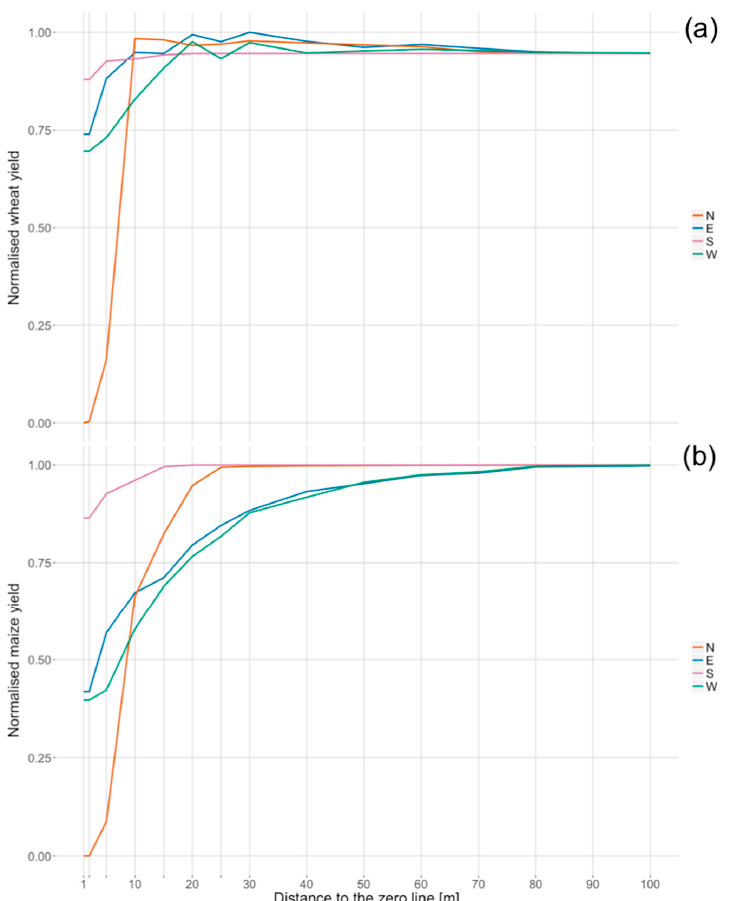
Figure 5. Simulated yields for wheat ( a ) and maize ( b ), in the four cardinal directions (north, east, south, and west), with respect to the distance to the zero line and the resulting shading of a forest matrix. The mean values of the annual simulations for 30 years of climate data are shown.